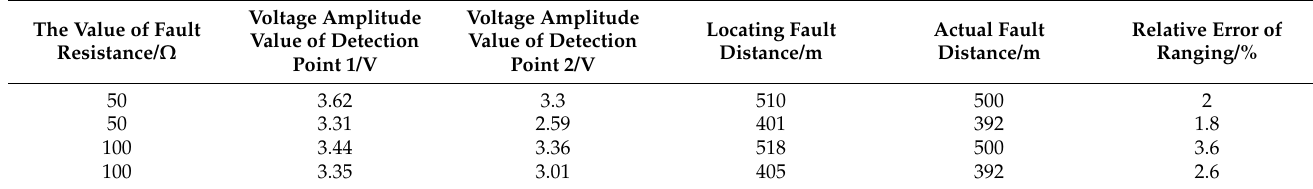
Table 6. Location results of different fault